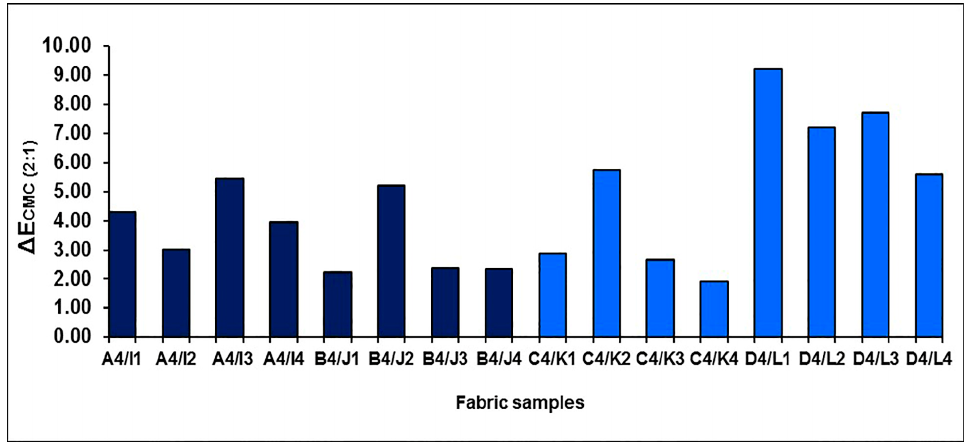
Figure 16. The color differences between fabrics with and without mixing component of black yarn .